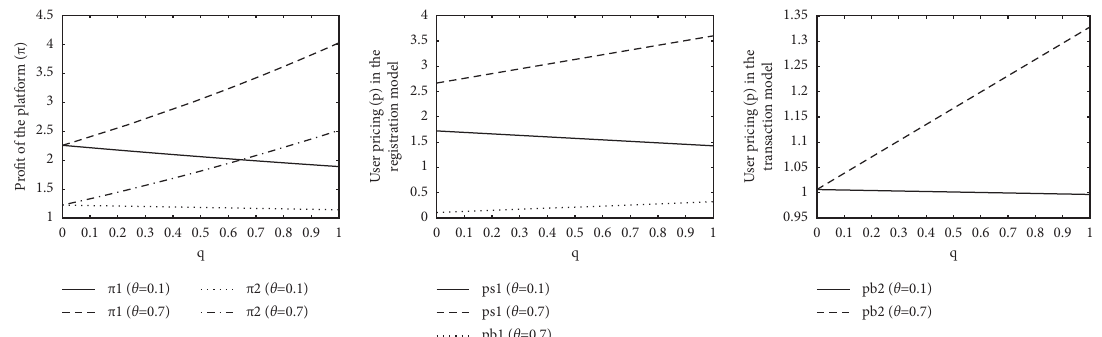
Figure 5: The impact of platform content quality on profit and user pricing.